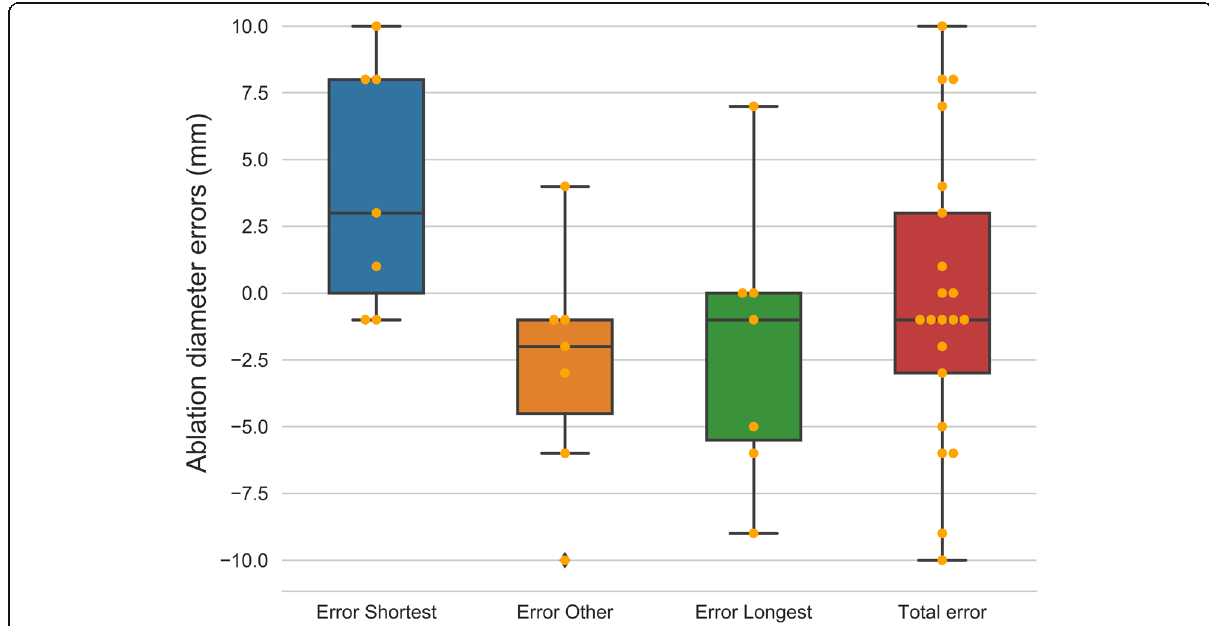
Fig. 5 Boxplots of the errors of the resulting diameters for the three directions measured and the “ total error ” taking into account every measurement. All values are in millimeter